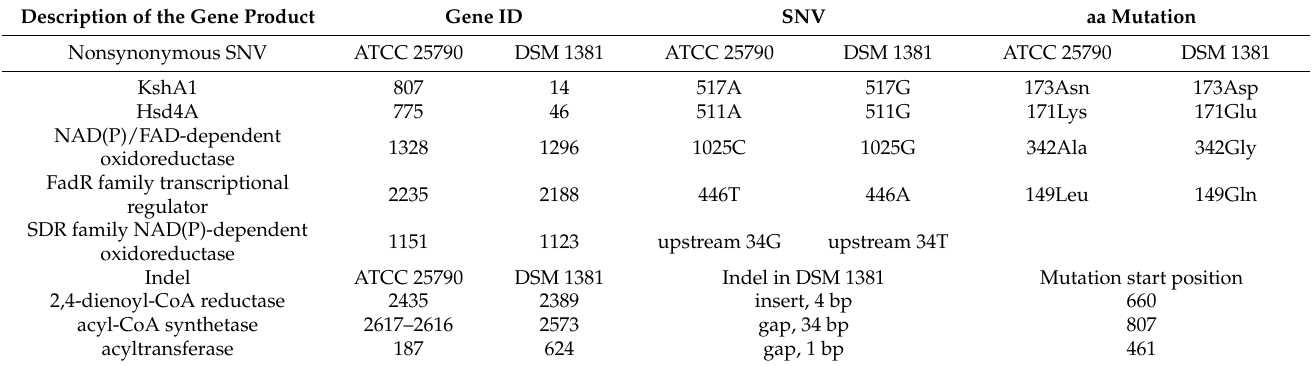
Table 2. The mutated genes in M. neoaurum DSM 1381 predicted to be responsible for steroid degradation. Description of the Gene Product Gene ID aa